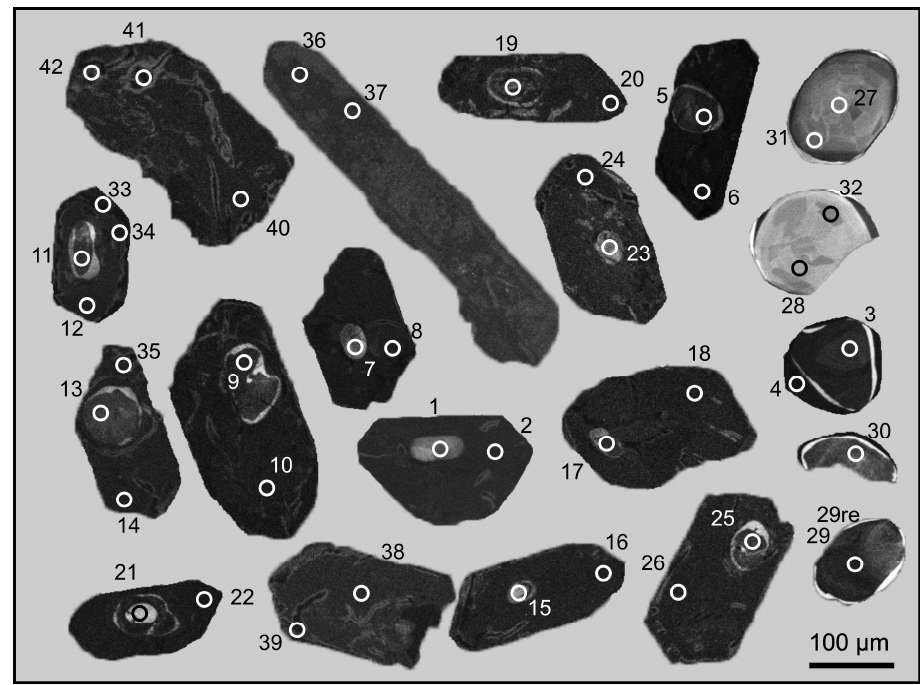
Figure 3. CL images of zircons from the pegmatite vein (sample 101d). Circles indicate the SIMS analytical spots with their numbers corresponding to those in Tables S1 and S2.